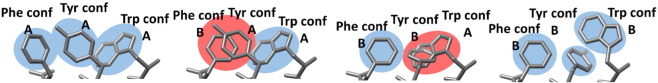
Alternate side-chain conformations using the CONTACT algorithm can be used to generate a network. For example, when the Phe sidechain transitions to conformation B there is a clash in the van der Waals radii with the Tyr sidechain. This clash is alleviated by switching Tyr to conformation B, which induces another clash which is then relieved by changing the Trp conformation. This process is repeated until there are no more steric clashes. This figure was adapted from Ref. [58].